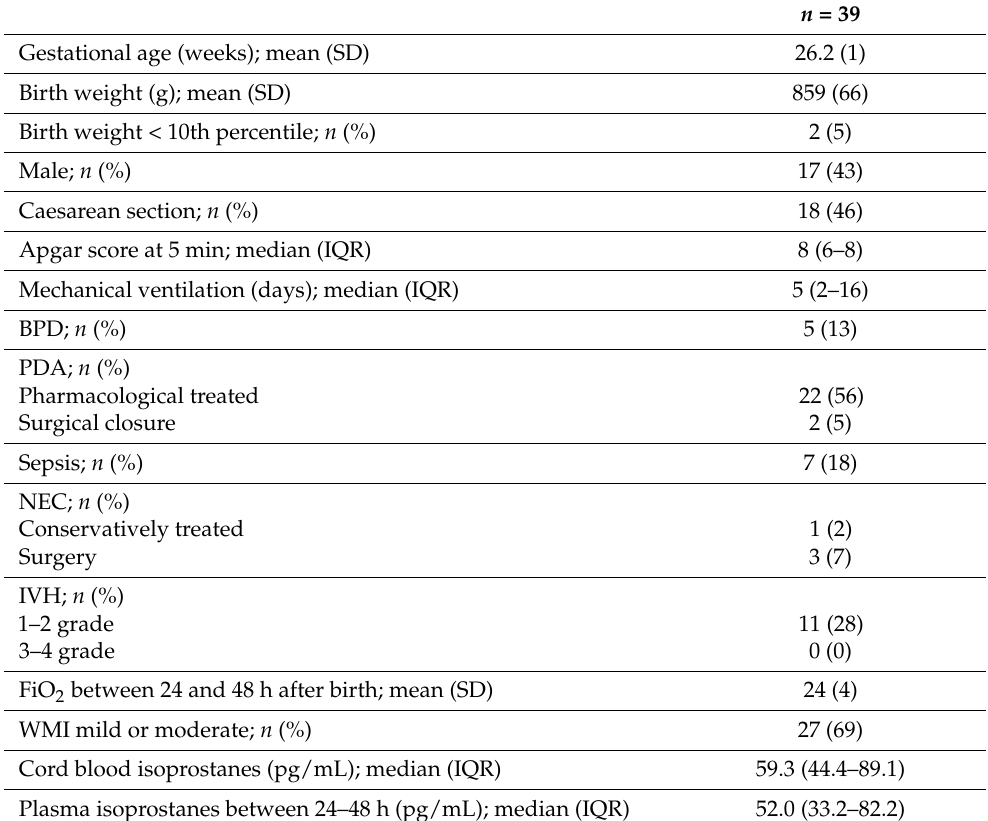
Table 1. Clinical characteristics of the enrolled newborns. Mean (SD), number (percentage) or median (IQR).